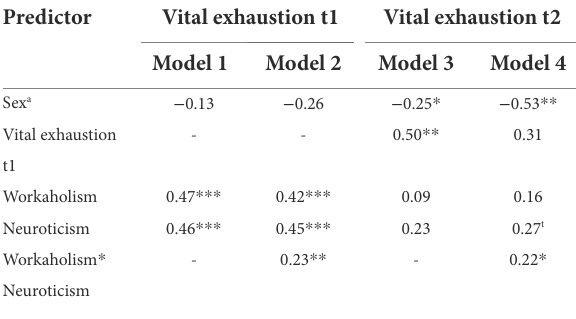
TABLE 2 Results of the multiple regression analyses predicting vital exhaustion t1 ( N = 42) and t2 ( N = 39). Predictor Vital exhaustion t1 Vital exhaustion